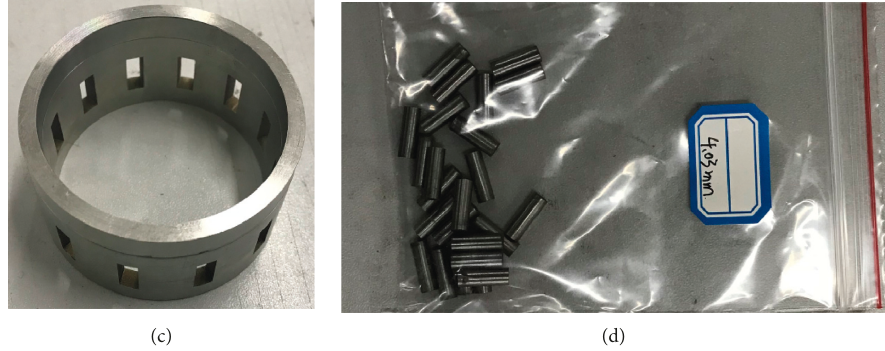
Figure 8: Elements in the bearing sample: (a) bushing, (b) shaft, (c) floating sleeve, and (d) rollers.